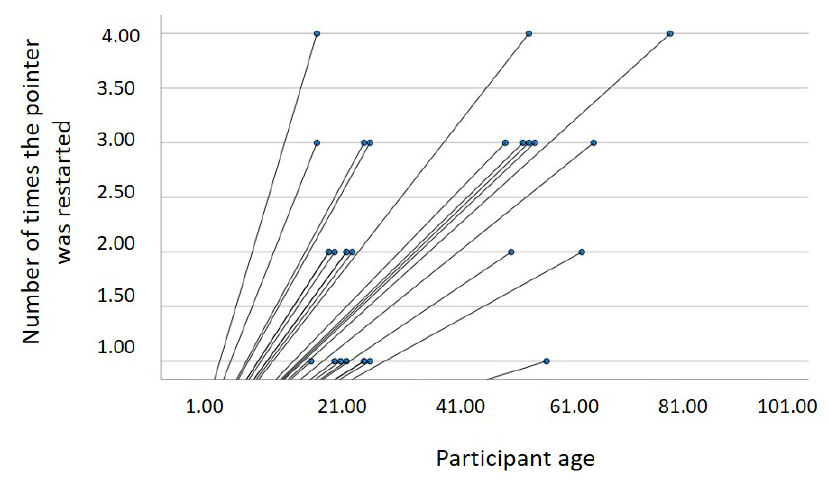
Figure 14. Relationship between age and number of times the pointer was restarted. Hypothesis 4. Age is associated with the degree of ease using the emulator.